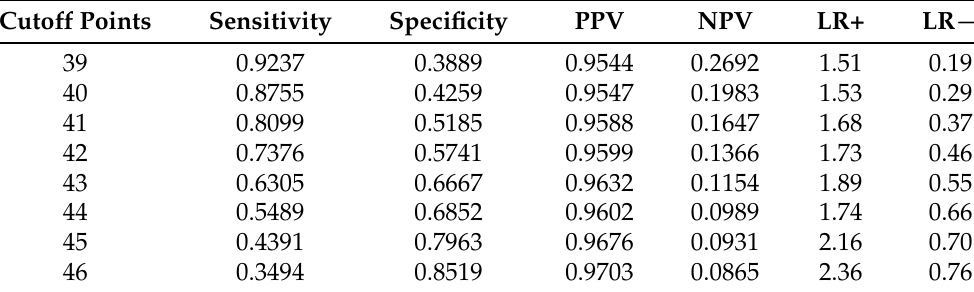
Table 5. ROC analysis for the discrimination between OSA and normal control subjects, based on neck circumference. ROC = receiver operator characteristic, PPV = positive predicted value, NPV = negative predicted value, LR+ = positive likelihood ratio, LR − = negative likelihood ratio.